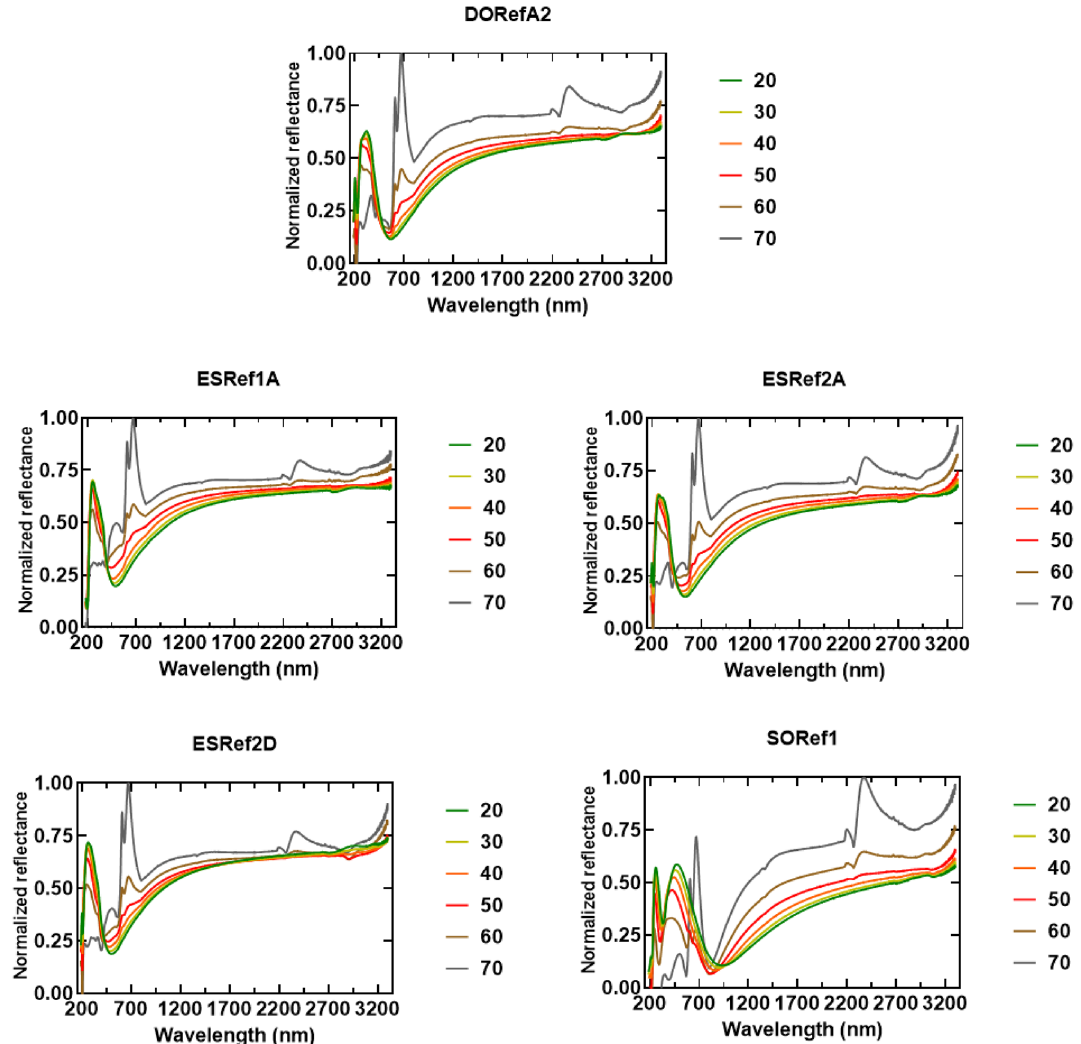
Figure 4. UV–Vis–NIR reflectance spectra (200–3300 nm) of single-layer films fabricated by spin coating 1% w/w reflectin in HFIP onto clean Si wafers. The angle of incidence was varied between 20° and 70° (10°